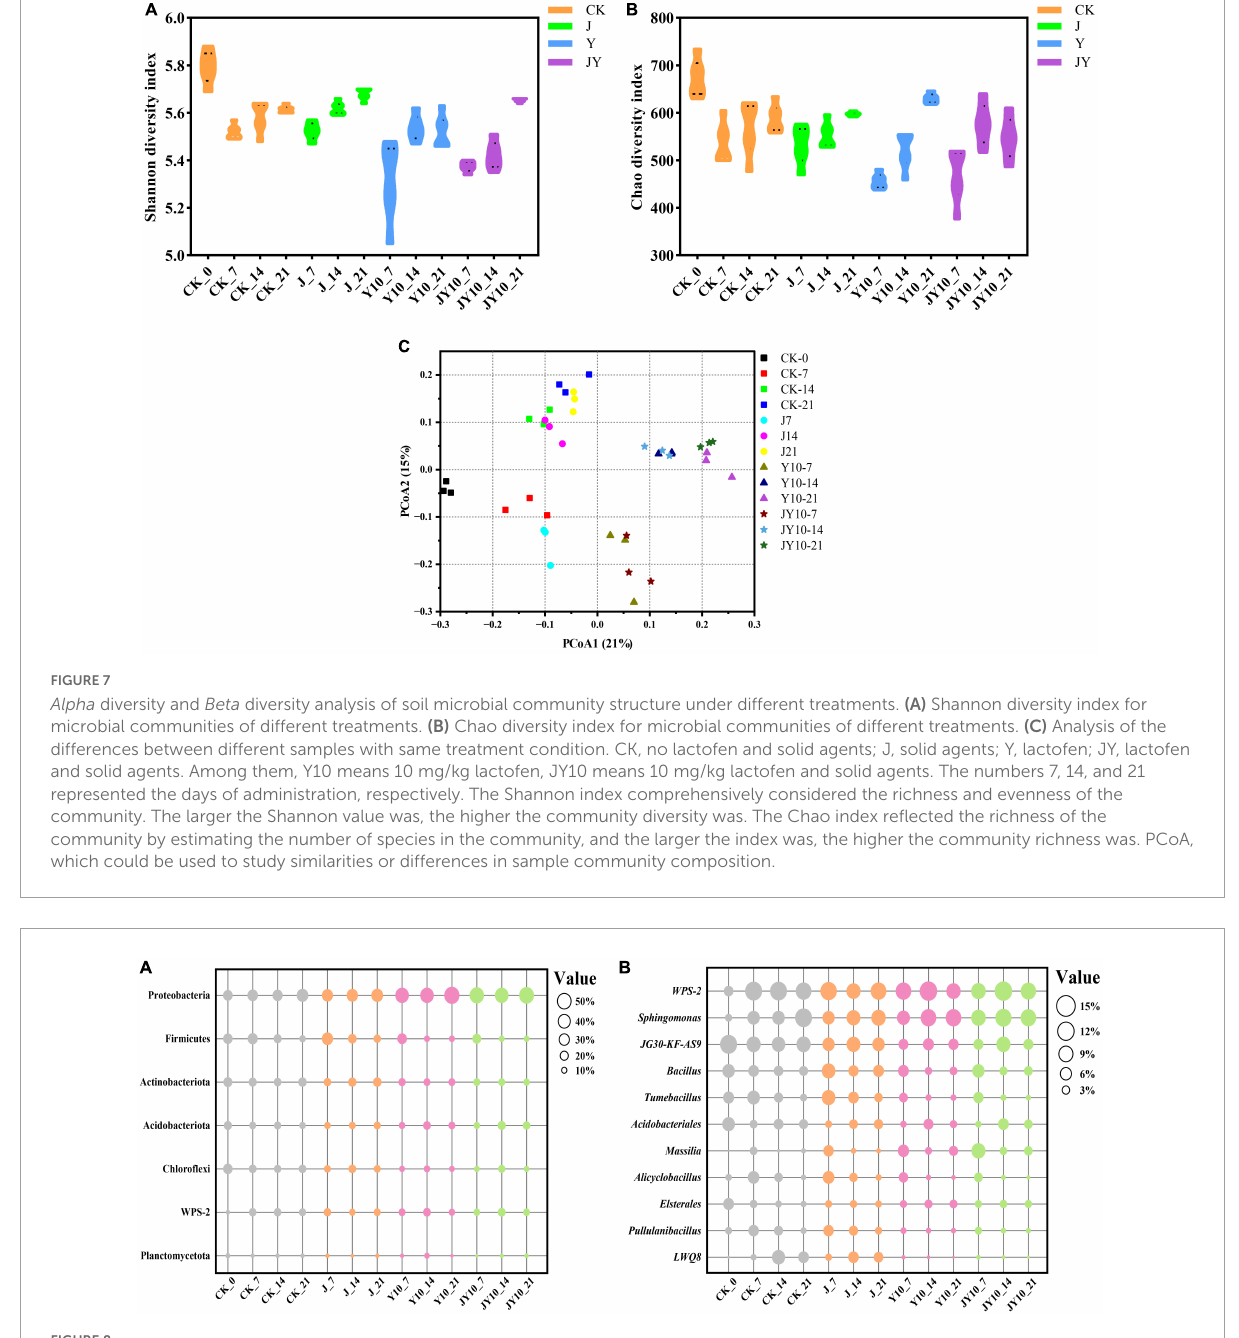
FIGURE8 Community composition analysis of soil bacteria at phylum (A) and genus (B) levels under different treatment conditions. CK, no lactofen and solid agents; J, solid agents; Y10, 10 mg/kg lactofen; JY10 mg/kg lactofen and solid agents. The numbers 7, 14, and 21 represented the days of administration, respectively. Bubble sizes represented relative percentages of different